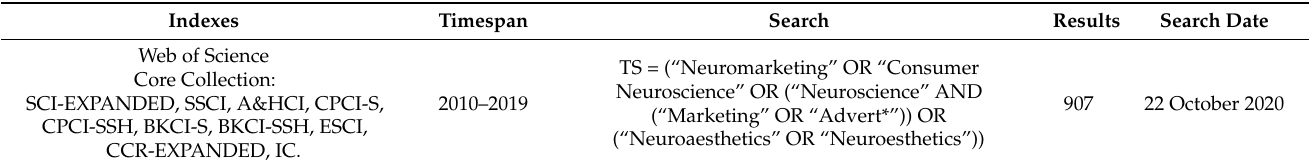
Table 1. Querying from Clarivate Analytics